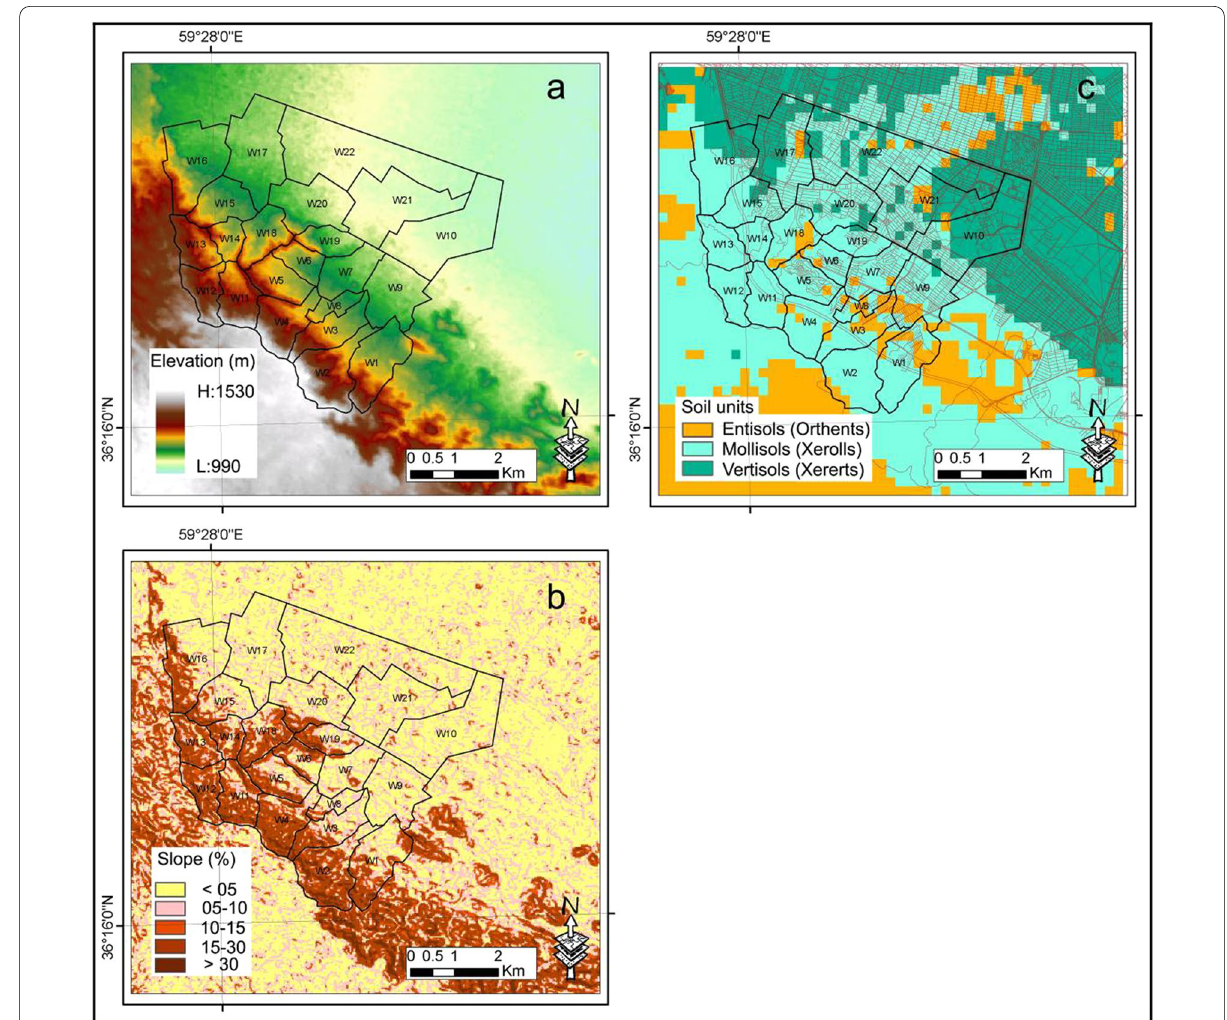
Fig. 3 Land characteristics of the study area including a elevation, b slope, and c soil